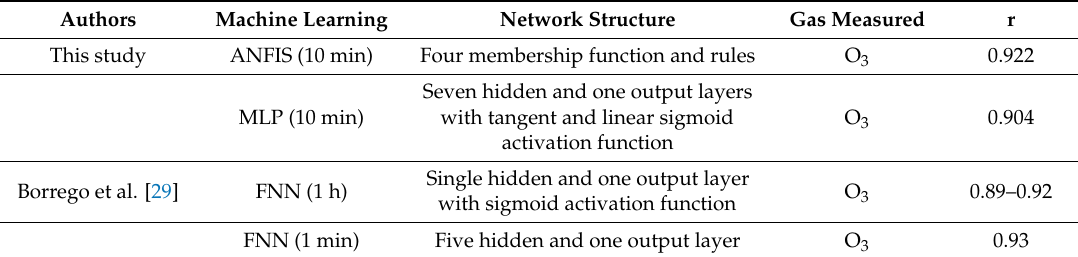
Table 7. Comparison calibration model for EC O 3 sensor with previous